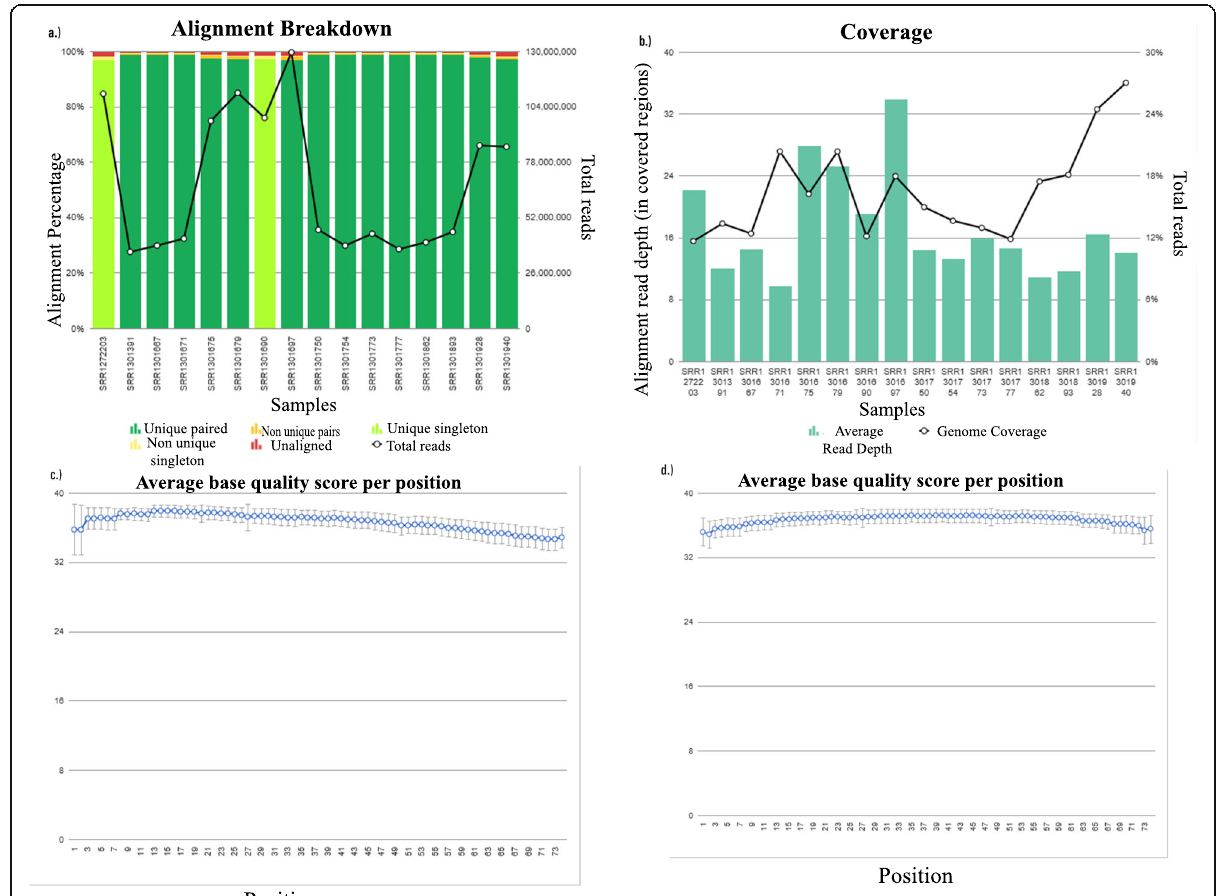
Fig. 1 Representative pre- and post-alignment quality check, coverage, and scores for the datasets under study. The graphs represent the quality check scores, alignment breakdown, and average base quality scores and validate the proper alignment of the datasets against the hg19 human reference